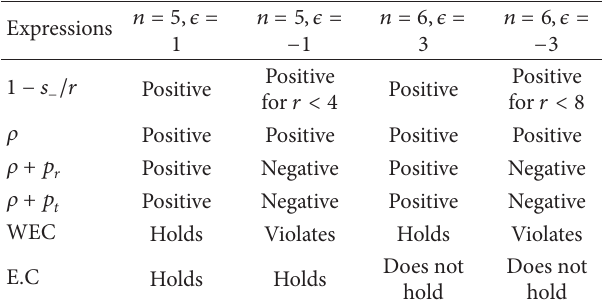
Table 2: Wormhole solutions with Gaussian distributed noncom- mutative framework for 𝑠 − .